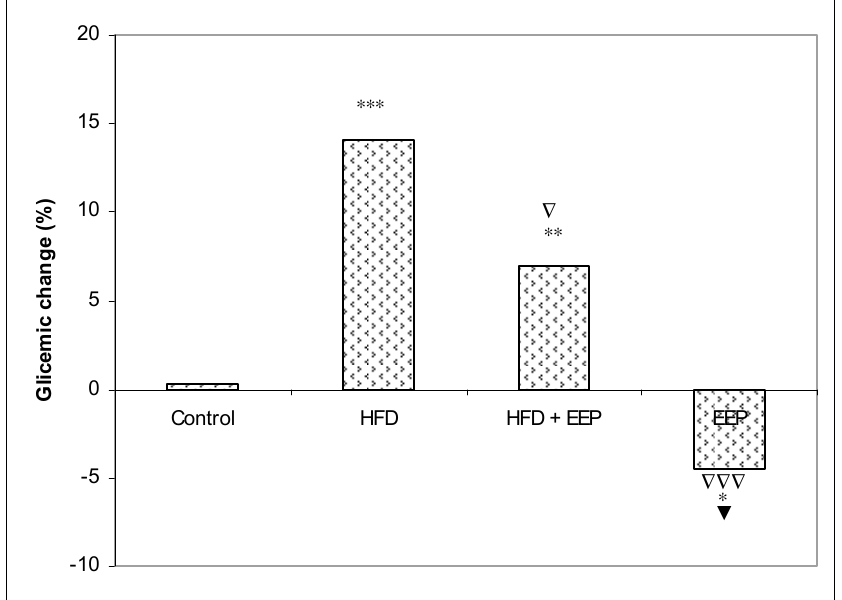
Figure 9. Effect of ethanol extract of propolis on percentage of glycemic change. Mice were given HFD, HFD + EEP at a dose 50 mg / kg or EEP (50 mg / kg) once daily for 30 days by a single HFD, HFD + EEP at a dose 50 mg/kg or EEP (50 mg/kg) once daily for 30 days by a single intragastric application. The percentage of glycemic changes was calculated according to the formula: Glycemic changes (%) = (G x − G 0 ) / G 0 × 100, where G 0 = blood glucose level at 0 day and G x = blood glucose level at 30 day. Number of mice per groups: nine. * Significantly different from the control group (* p ≤